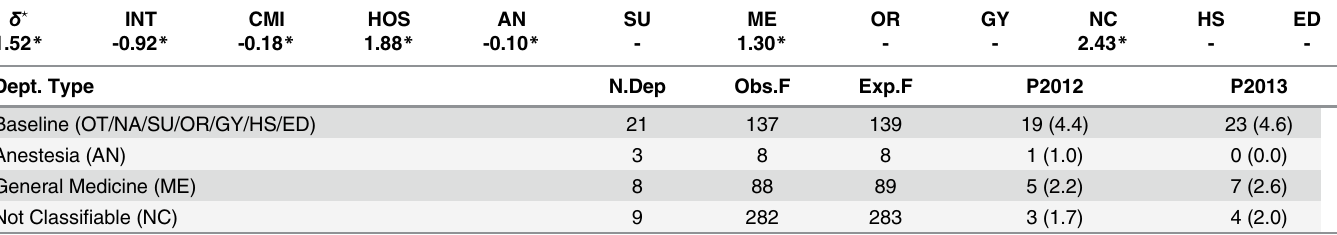
Table 9. Results for monetary damages, for the Liguria region. Estimates of the parameters of the Poisson model as per Appendix 2.1, number of depart- ments of a given type that generated each alleged type of claim (N.Dep), observed frequencies of claims for the different types of departments (Obs.F), expected frequencies according to the model (Exp.F), and predicted claims for 2012 (P2012) and 2013 (P2013), together with their standard deviations (in brackets). δ